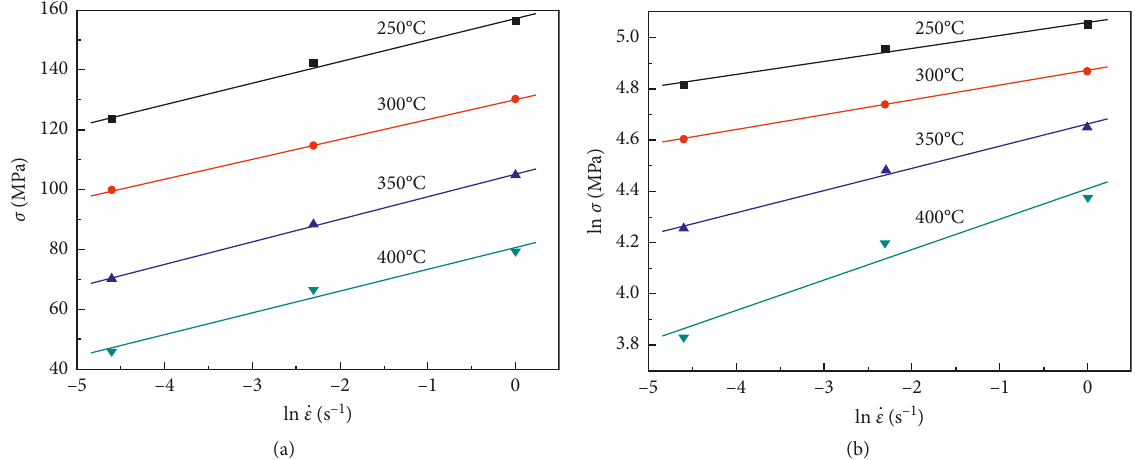
Figure 2: Curves of peak stress versus strain rate and temperature under different conditions: (a) σ − ln _ ε ; (b) ln σ − ln _ ε